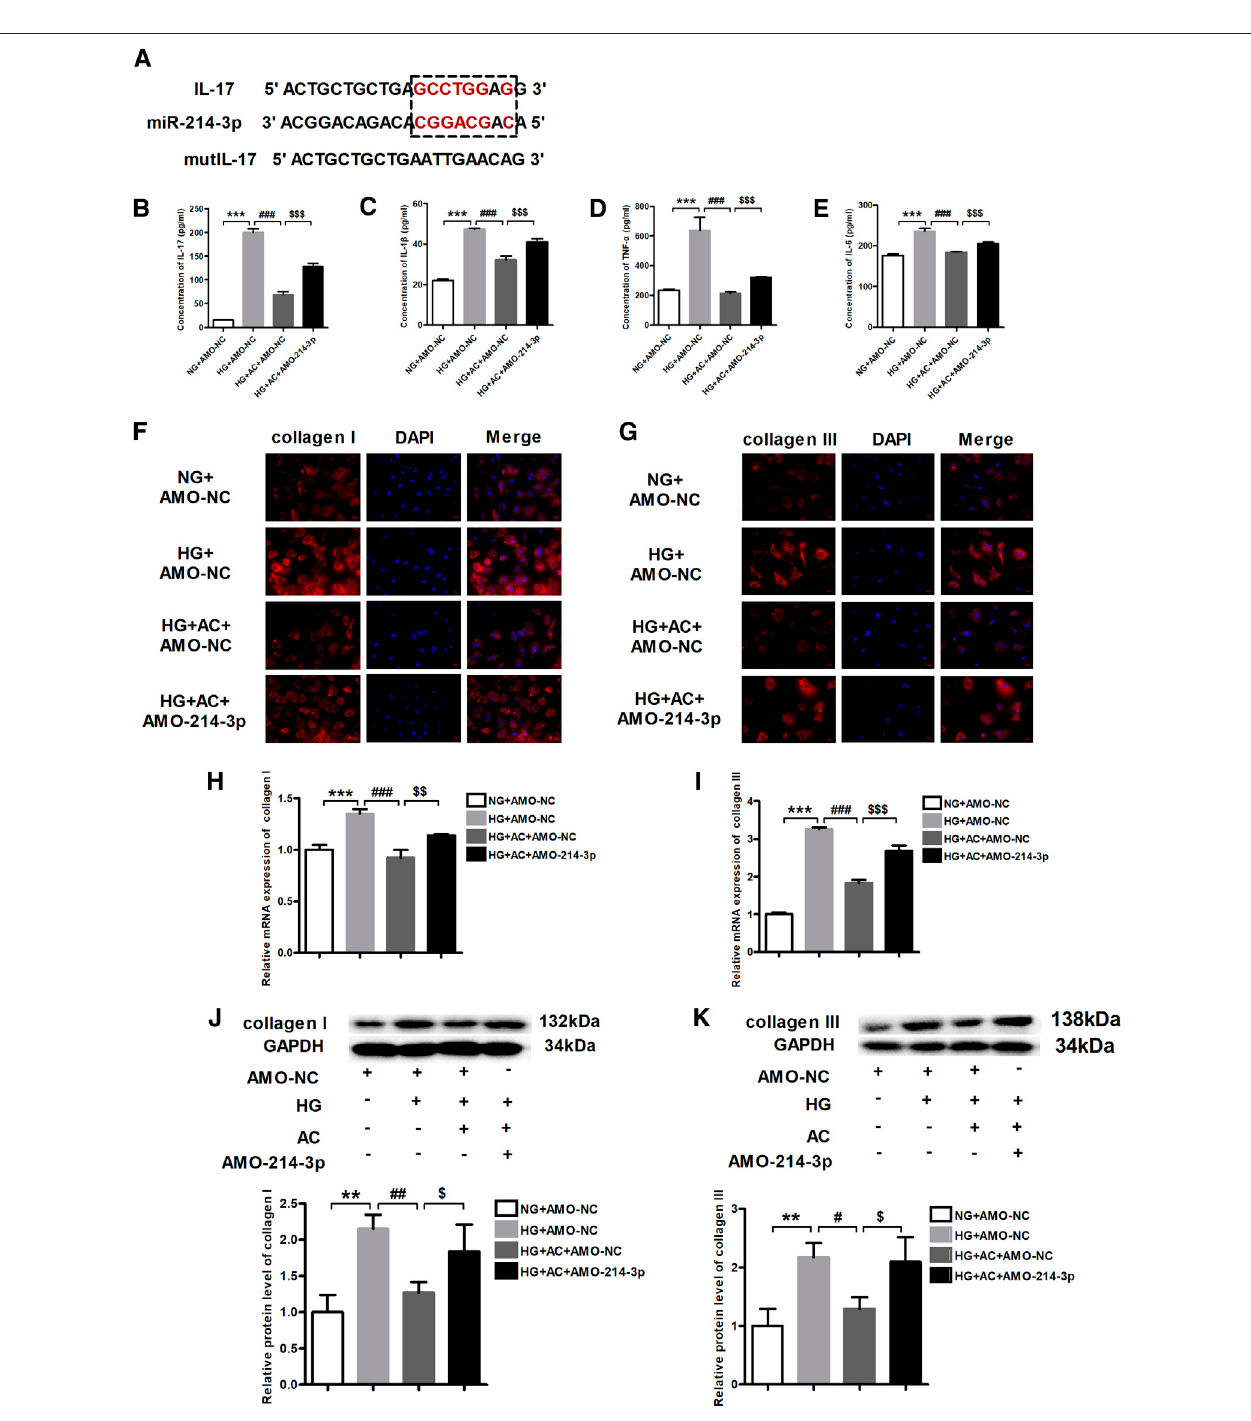
FIGURE 5 | Anthocyaninsuppressesin fl ammationandmyocardial fi brosisbyinhibitinginterleukin(IL)-17throughmiR-214-3p. (A) BindingtargetsbetweenmiR-214-3pand IL-17. (B) ConcentrationofIL-17detectedbyenzyme-linkedimmunosorbentassay(ELISA). (C) ConcentrationofIL-1 β detectedbyELISA. (D) ConcentrationofTNF- α detectedby ELISA. (E) Concentration of IL-6 detected by ELISA. (F) Immuno fl uorescence staining of collagen I. Scale bar: 20 μ m. (G) Immuno fl uorescence staining of collagen III. Scale bar: 20 μ m. (H) Relativeexpression ofcollagen ImRNAdetectedusingquantitativereversetranscription PCR(qRT-PCR). (I) Relativeexpression ofcollagenIIImRNA. (J) Relative proteinlevelofcollagenI. (K) RelativeproteinlevelofcollagenIII.GAPDHservedasaninternalcontrol.** p < 0.01vs.NG+AMO-NC,*** p < 0.001vs.NG+AMO-NC,# p < 0.05vs. HG+AMO-NC,## p < 0.01vs.HG+AMO-NC,### p < 0.001vs.HG+AMO-NC,$ p < 0.05vs.HG+AC+AMO-NC,$$ p < 0.01vs.HG+AC+AMO-NC,$$$ p < 0.001vs.HG+ AC+AMO-NC.NG+AMO-NC,normalglucose(5.5 mM)+AMO-Negativecontrol;HG+AMO-NC,highglucose(25 mM)+AMO-NC;HG+AC+AMO-NC,25 mMglucoseand 250 μ g/ml anthocyanin + AMO-NC; n (cid:1) 3.